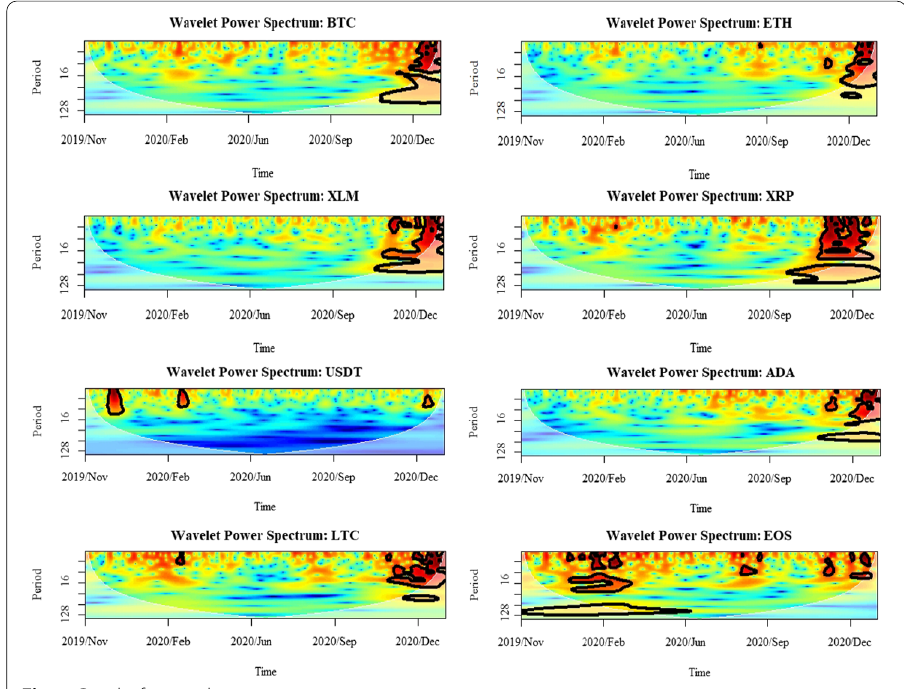
Fig. 5 Results for wavelet power